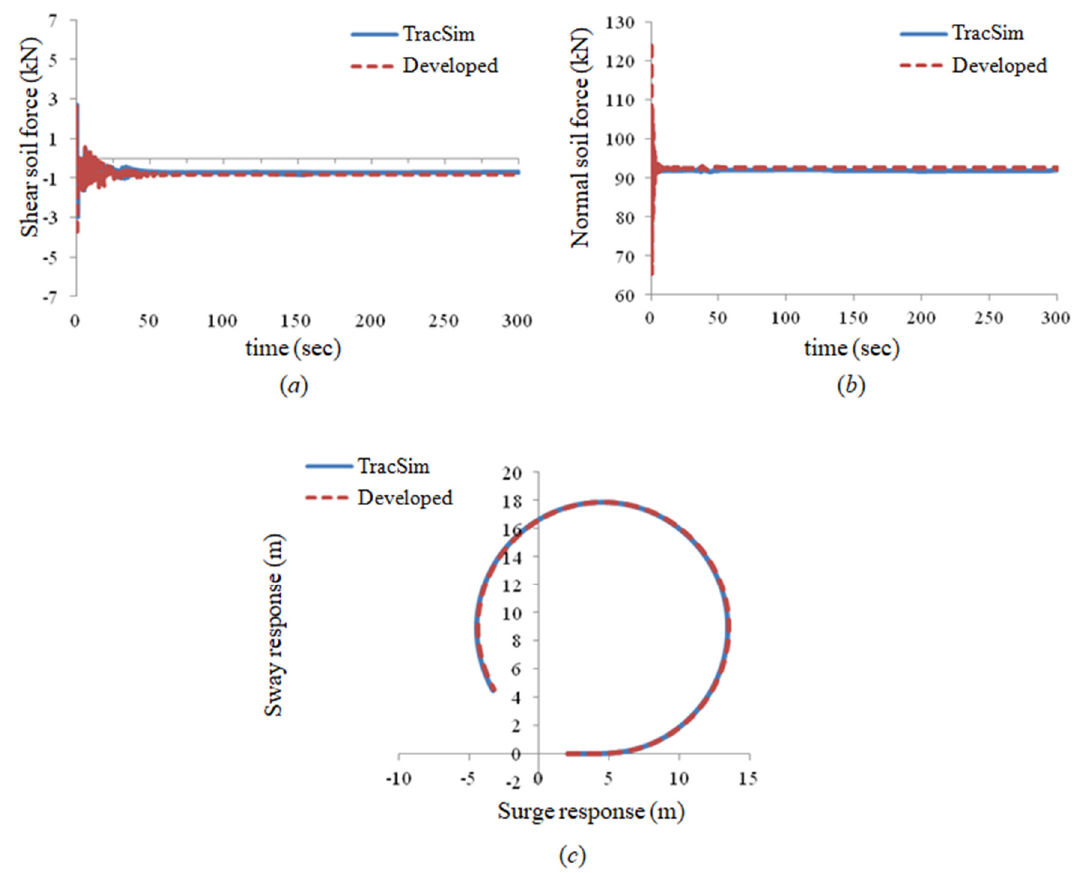
Figure 30. Comparison of the steering drive dynamic analysis results between the developed method and Tracsim: ( a ) shear soil contact force acting on mining robot, ( b ) normal soil contact force acting on mining robot, ( c ) steering radius of the mining robot.